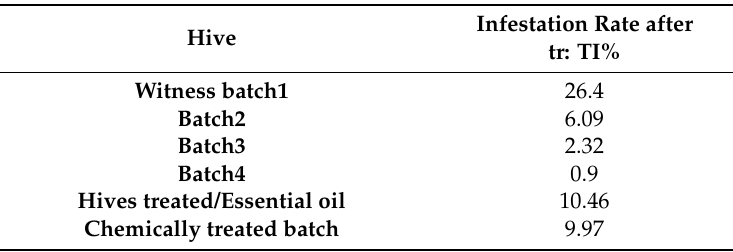
Table 2. Estimation of the infestation rate in different hives and batches after inhalation treatment with sage essential